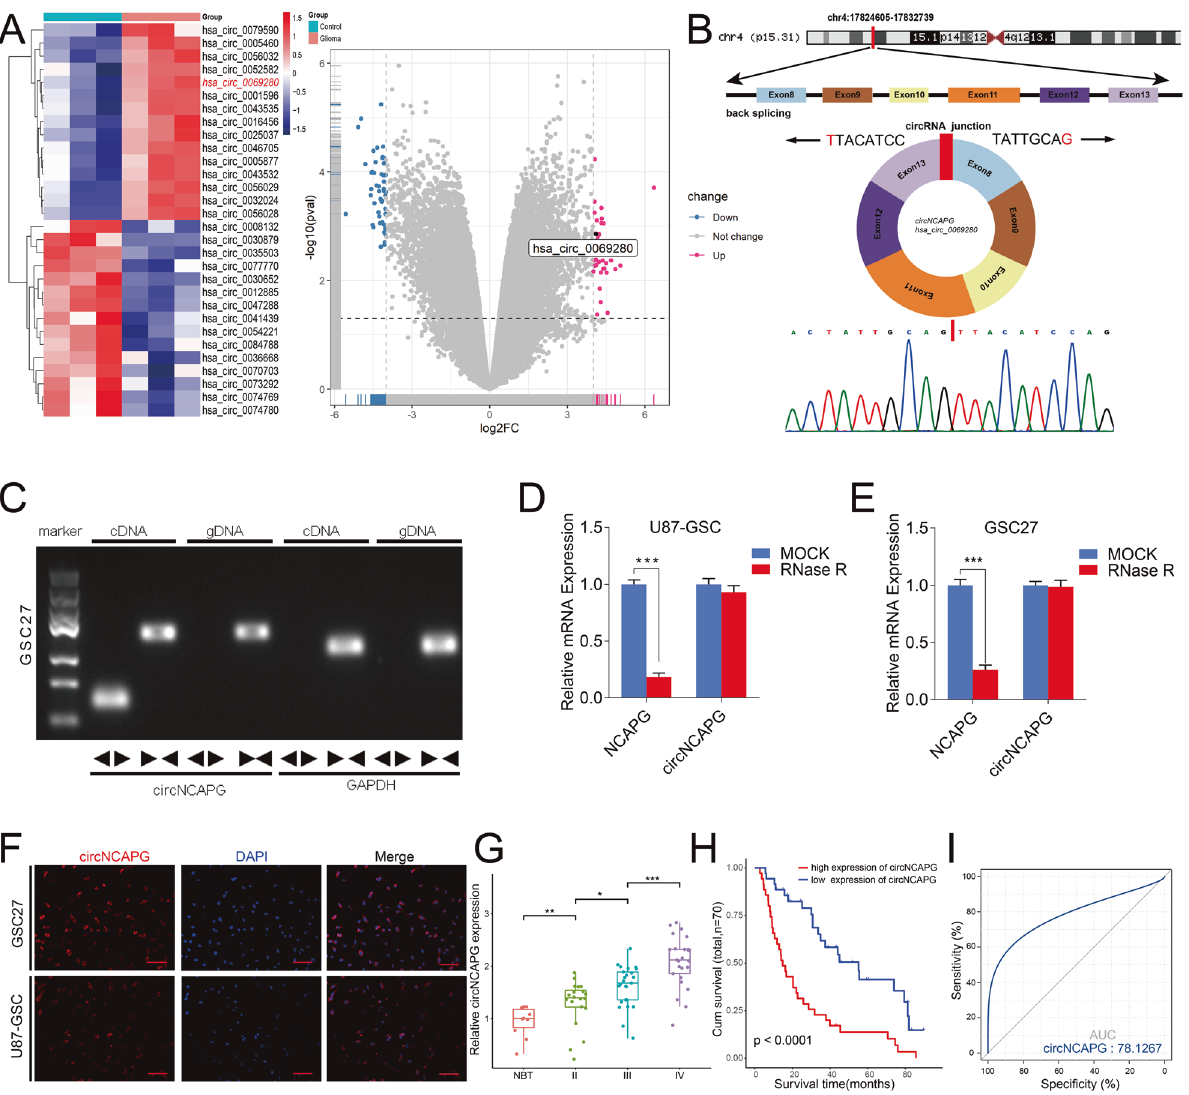
B Diagram showing the formation of circNCAPG via exon8-13 back-splicing from linear NCAPG, and Sanger sequencing con fi rmed the backsplice junction site of circNCAPG. C Agarose gel electrophoresis analysis for PCR products from cDNA and gDNA. D , E The circNCAPG and NCAPG mRNA expression levels in U87-GSC and GSC27 after treatment with RNase R. F RNA FISH showed the localization of circNCAPG. Scale bar = 50 µm. G The expression of circNCAPG in NBTs and different WHO grade glioma samples. (NBT, n = 10; WHO grade II, n = 20; WHO